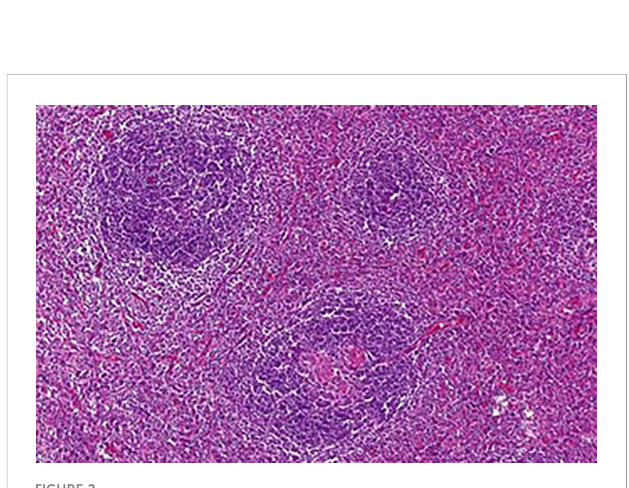
FIGURE 2 Some of the enlarged follicles were traversed by abnormal hyalinized vessels (lollipop sign). The interfollicular stroma was composed of a heterogeneous mixture of lymphocytes, plasma cells and occasional eosinophils.